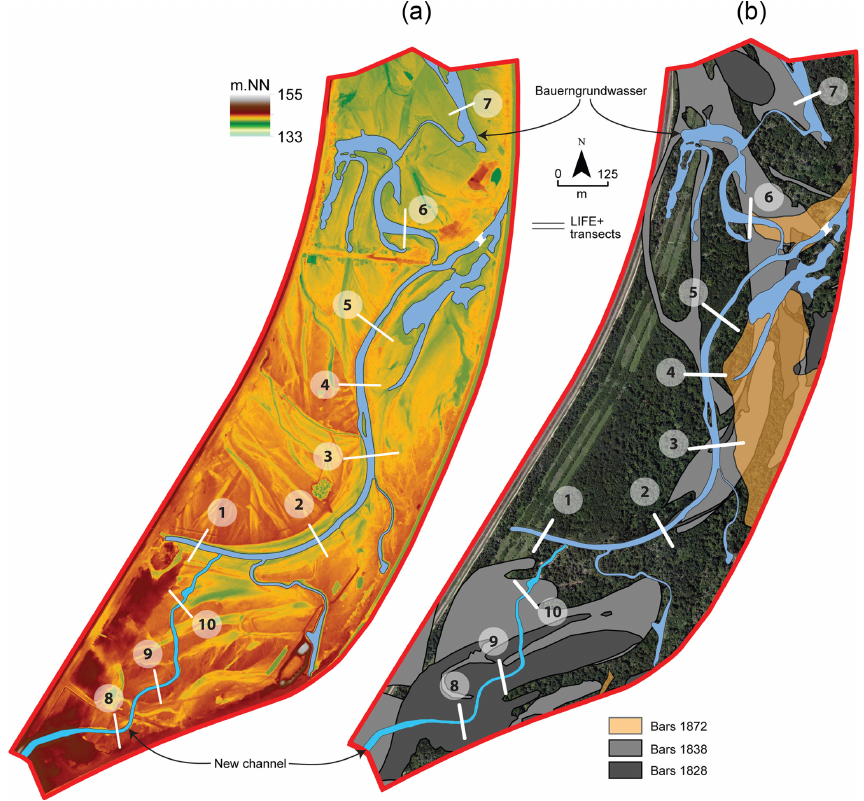
Figure 2. Digital elevation model of Rohrschollen Island (a) and location of the main gravel bars reconstructed from the geohistorical and sedimentological studies (b) . The black and white lines correspond to transects of hydrologic measurements (see Fig.